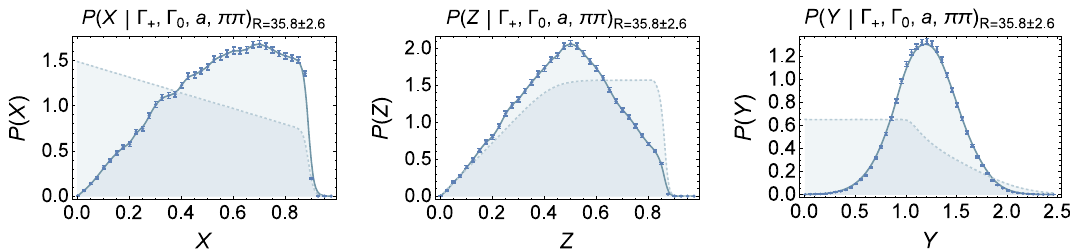
Fig. 4 Probability densities in comparison with the prior (transparent). R = 35 . 8 ± 2 . 6, η → 3 π and ππ scattering data. Smoothed. Error bars estimate the precision of the Monte Carlo integration